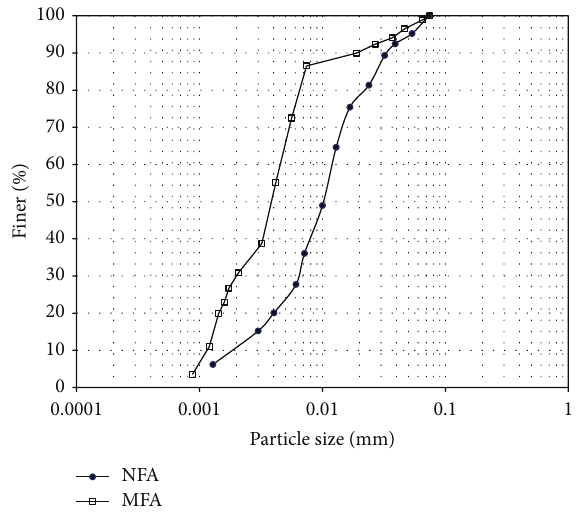
Figure 2: Particle size distribution curves of NFA and